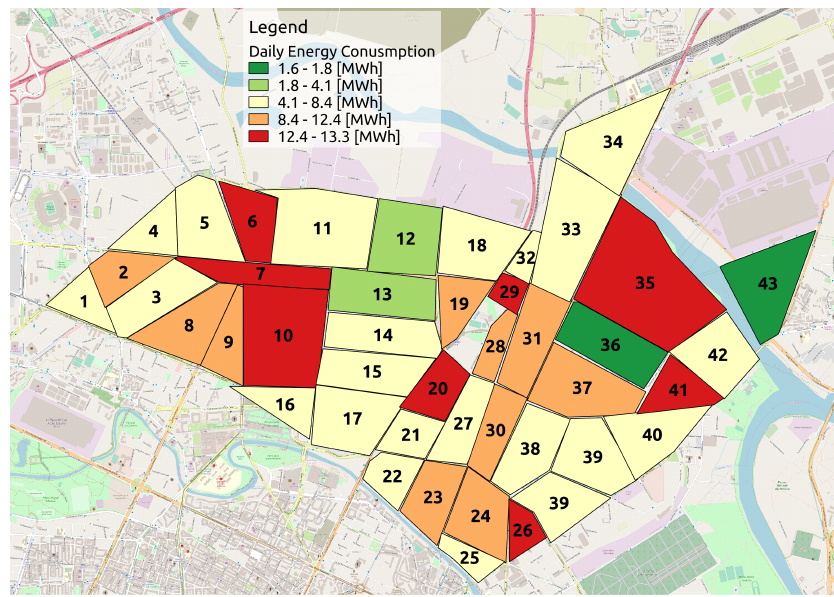
Figure 10. The actual energy consumption of buildings.